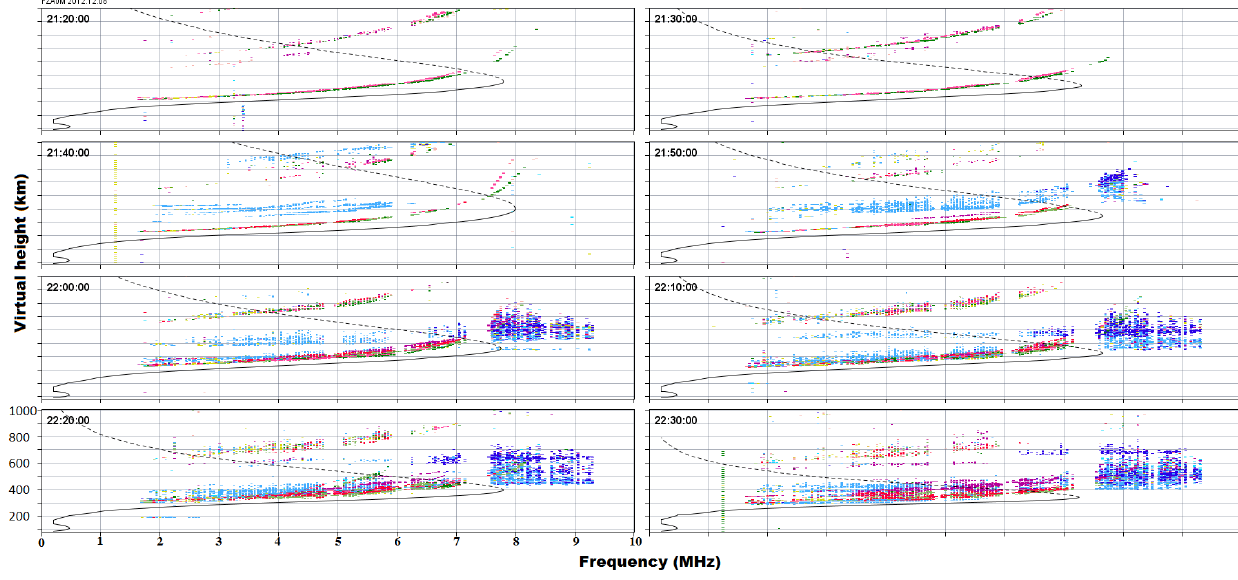
prior to the sunset. The spread F condition is evident in the ionograms for the rest of the